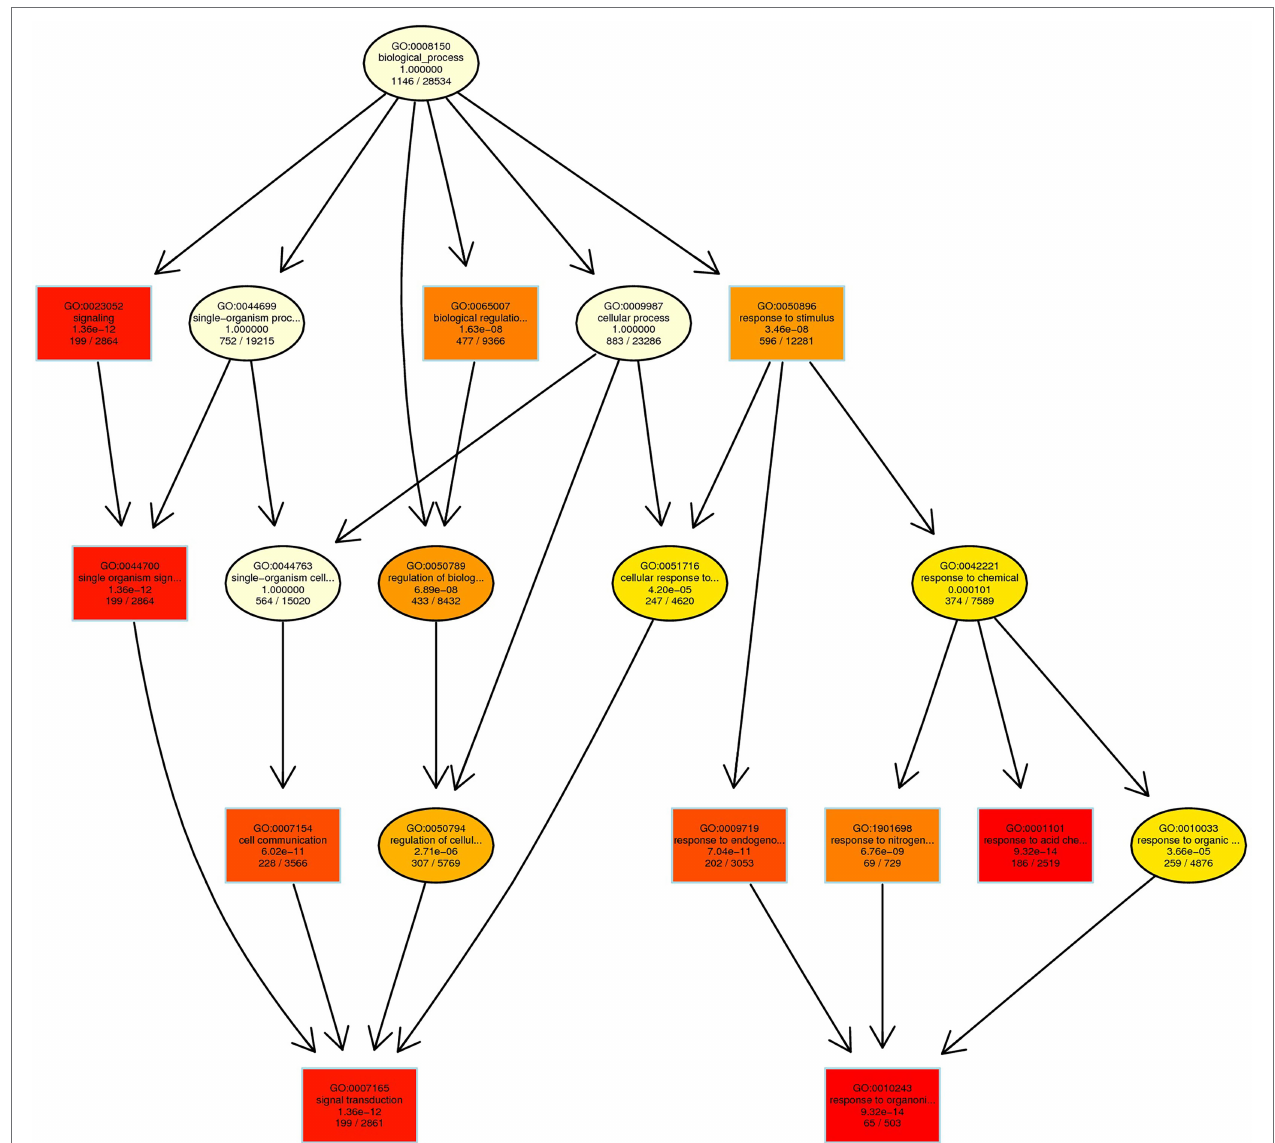
FIGURE 11 | Biological process-based enriched GO term in CK vs. T. Red to yellow color exhibiting the high to low enrichment DEGs in each GO